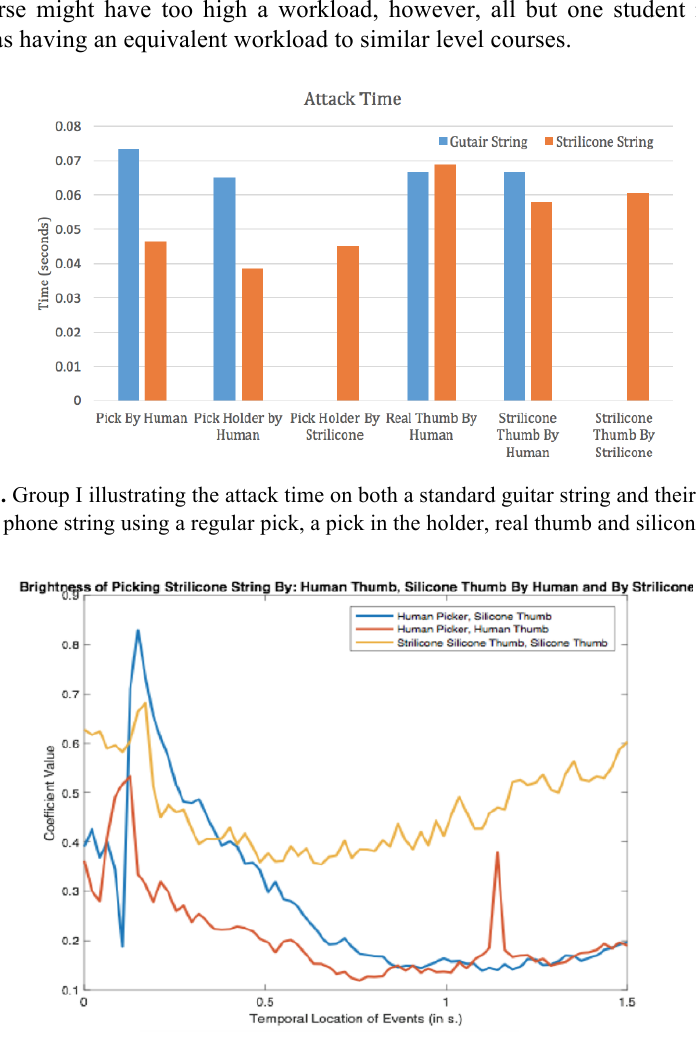
Fig. 22. Envelope of Group I’s response to a silicone thumb, real thumb, plucking a guitar string, and the chordophone